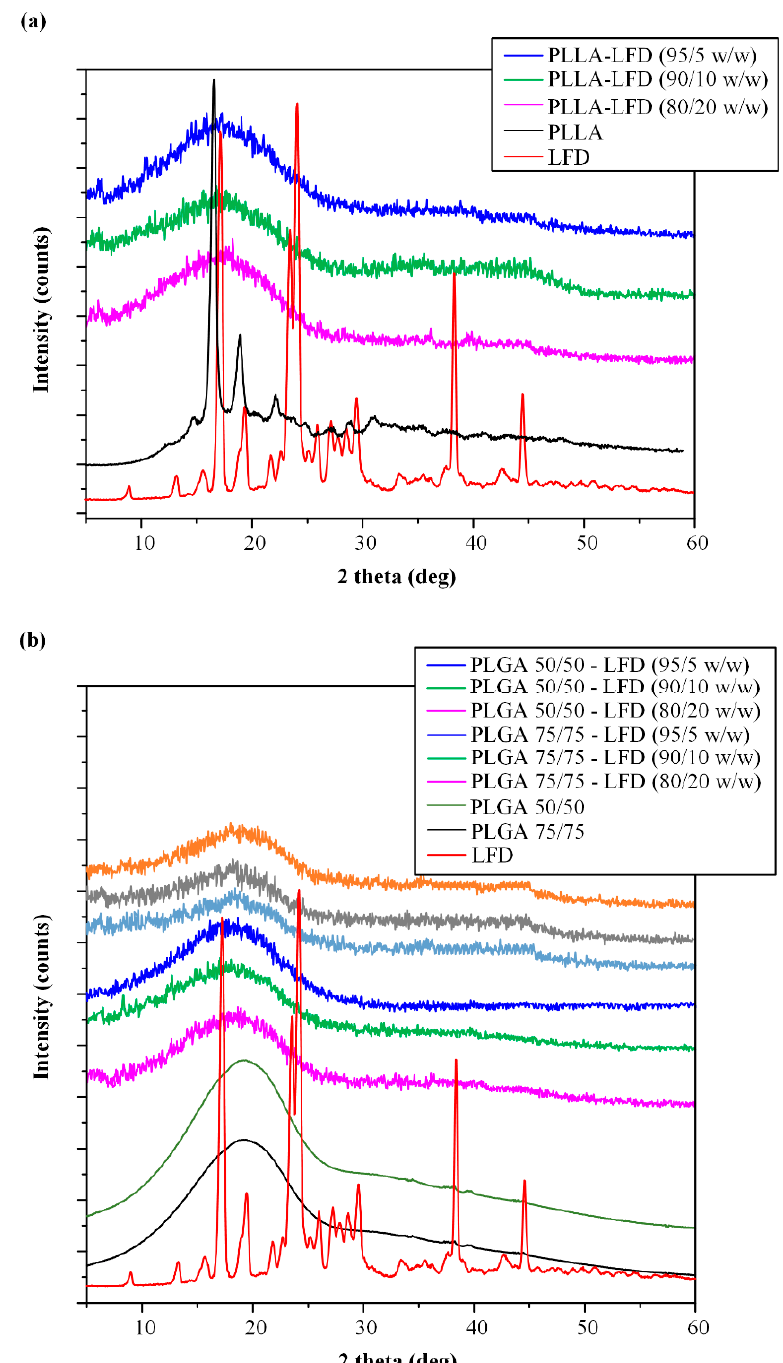
Figure 6. pXRD diffractograms of neat LDF-loaded PLLA ( a ) and PLGA ( b ) thin-film patches.